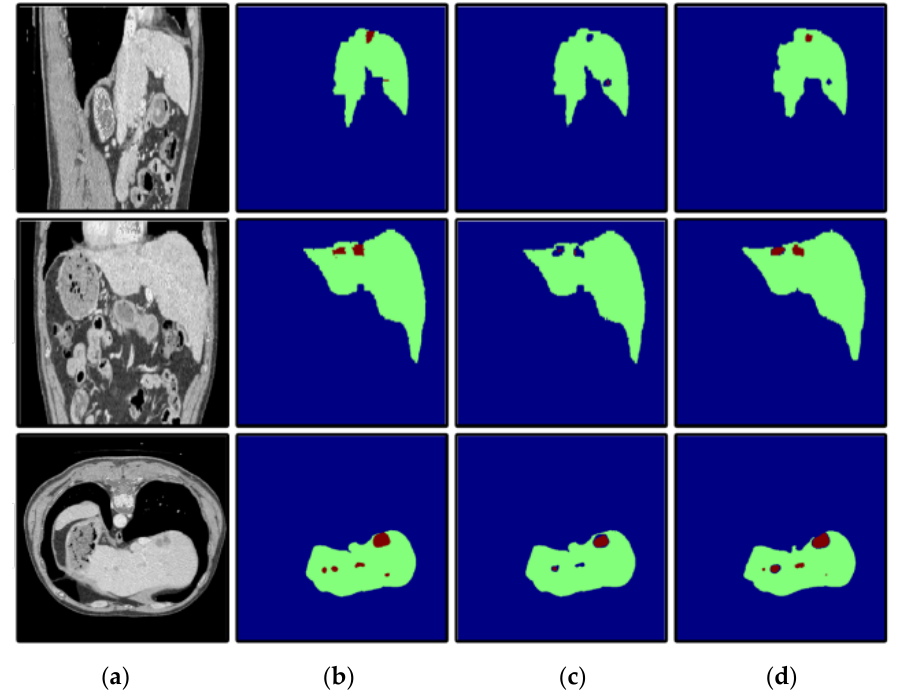
Figure 9. The influence of the attention mechanism on liver tumor segmentation results; the first row is the sagittal plane, the second row is the coronal plane, and the third row is the transverse plane. ( a ) CT original images; ( b ) the real segmentation results; ( c ) DCUNet-noAttention segmenta- tion results; ( d ) DCUNet-Tumor segmentation results.